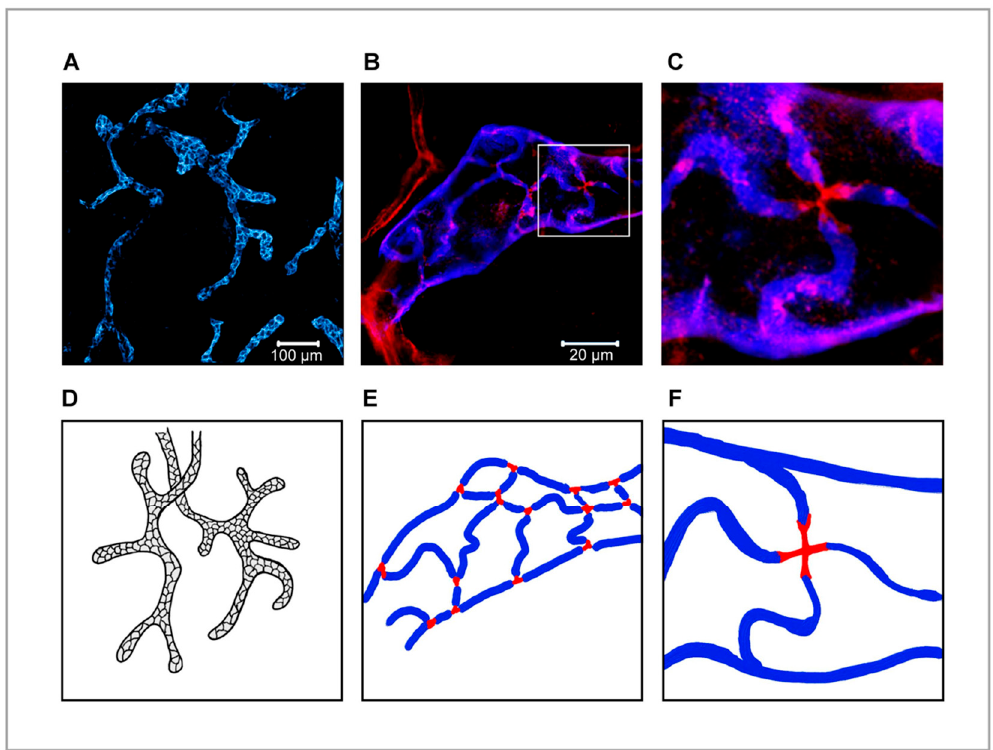
Figure 2. Functionally specialised junctions between endothelial cells of initial lymphatic vessels. ( A – C ), Blind-ended initial capillaries of whole mount mouse ear dermis, immunolabeled with anti-LYVE-1/AF647-conjugated anti-rabbit antibody (blue) and anti-VE-cadherin/AF568-conjugated anti-rat antibody (red) shown at low (100 × , panel A ) and high magnification (630 × , panel B ), with further digital zoom ( panel C ), to illustrate the arrangement of LYVE-1 along endothelial flaps pinned by VE-cadherin in button-like junctions where immune cells transmigrate (see text for details). The same images are re-drawn as illustration models in panels ( D – F ).